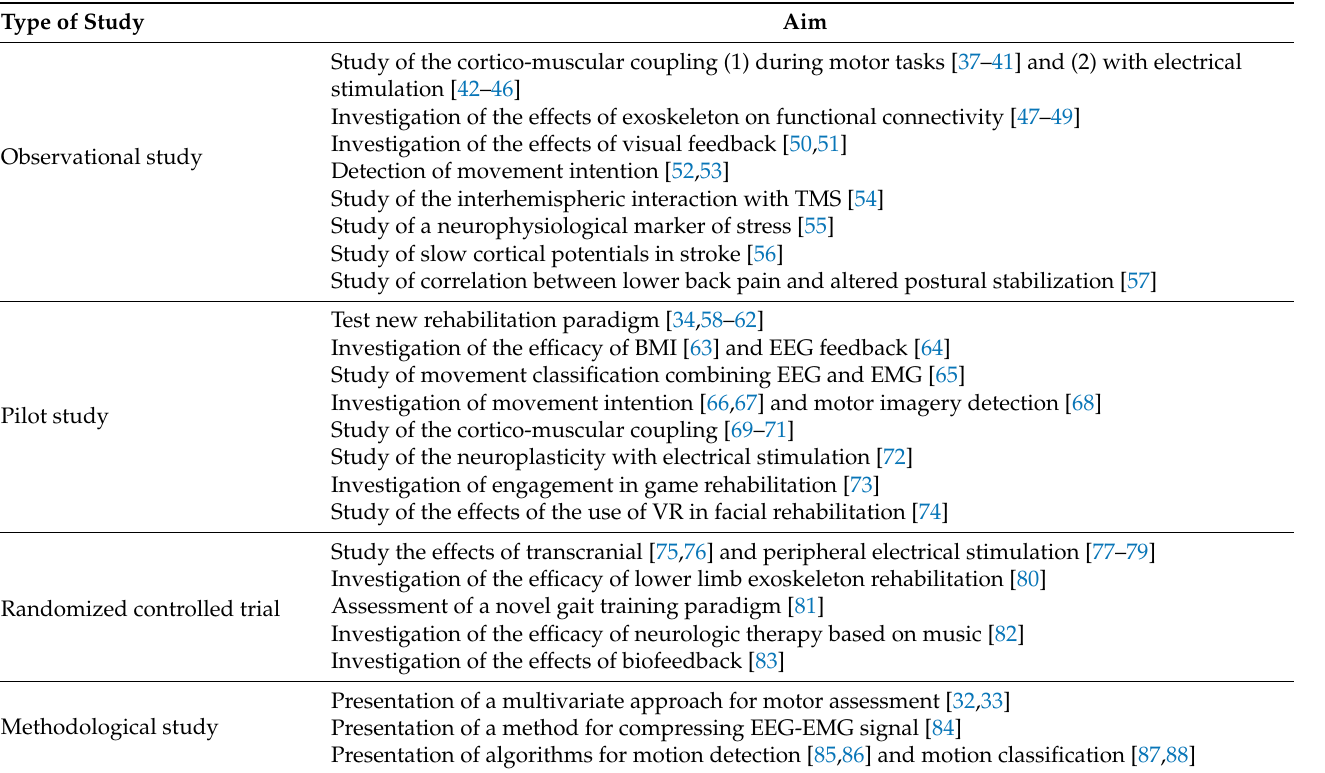
Table 1. Type of study and